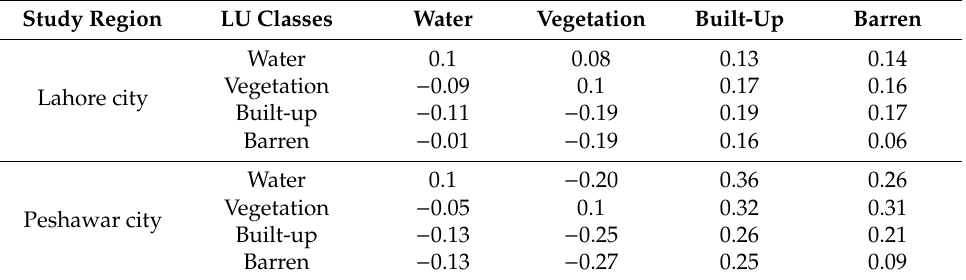
Figure 9. As Figure 8, for Peshawar city.